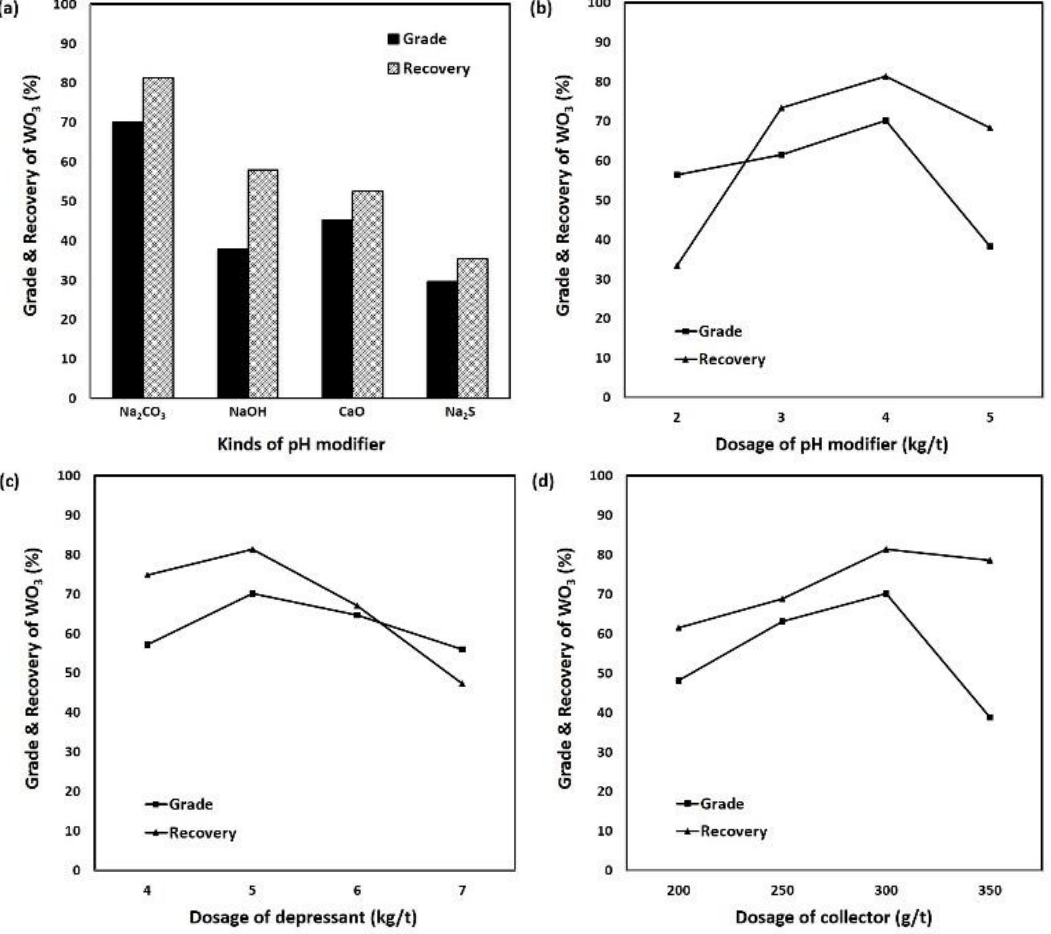
Figure 5. Effects of operation parameters on the scheelite flotation ( a ) kinds of pH modifier, ( b ) dosage of sodium carbonate as pH modifier, ( c ) dosage of sodium silicate as depressant, ( d ) dosage of oleic acid as collector, respectively .